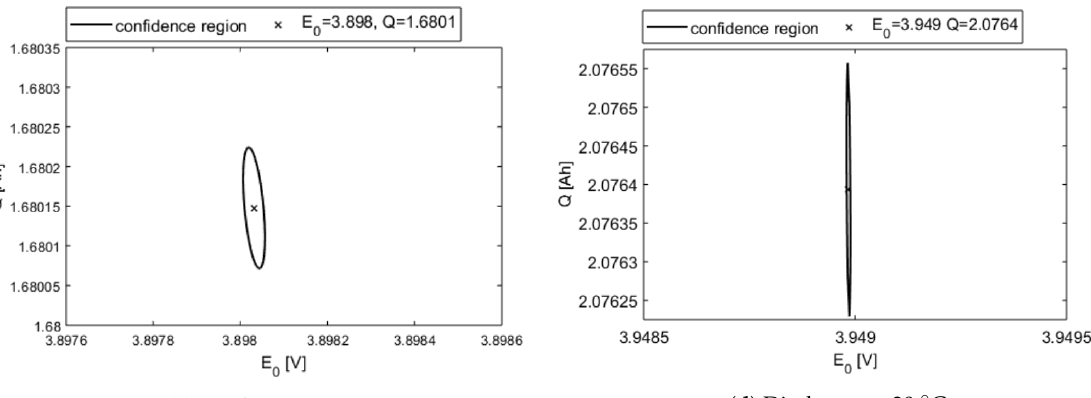
Figure 3. Confidence regions of the estimated parameters E 0 , Q during charge/discharge at different temperatures. x axis, E 0 ; y axis, Q ; x axis range, 1 × 10 − 3 ; y axis range, 3.5 × 10 − 4 ; − , confidence region; × , estimated parameter value.